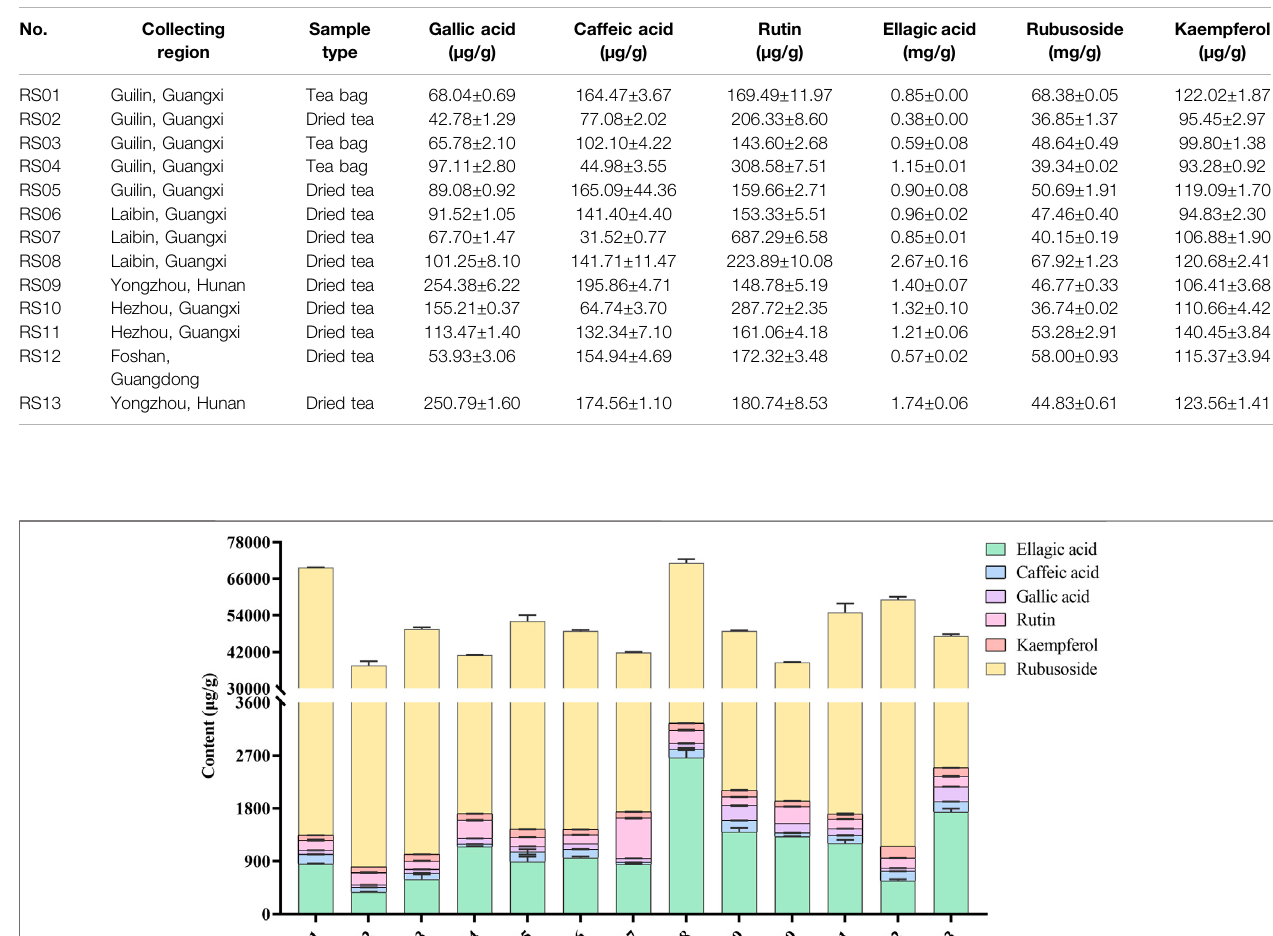
Frontiers in Pharmacology |